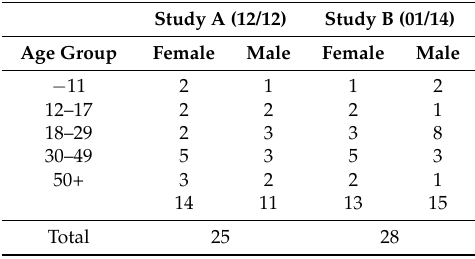
Table 1. Numbers and ages of participants in evaluation studies.